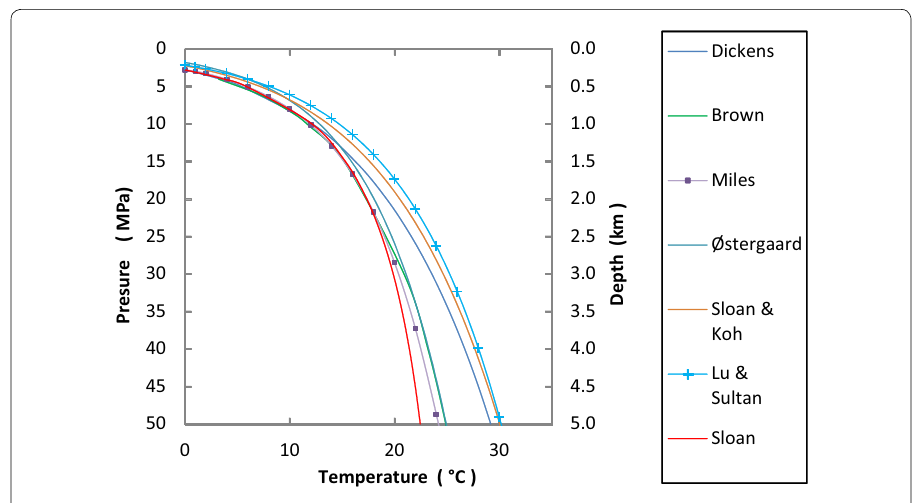
Fig. 7 Phase curves of Brown et al. (1996), Dickens and Quinby‑Hunt (1994), Lu and Sultan (2008), Miles (1995), Østergaard et al. (2000), Sloan (1998), Sloan and Koh (2007). These phase curves are the result of P, T point pairs obtained in laboratory and their respective adjustments (Gómez et al.